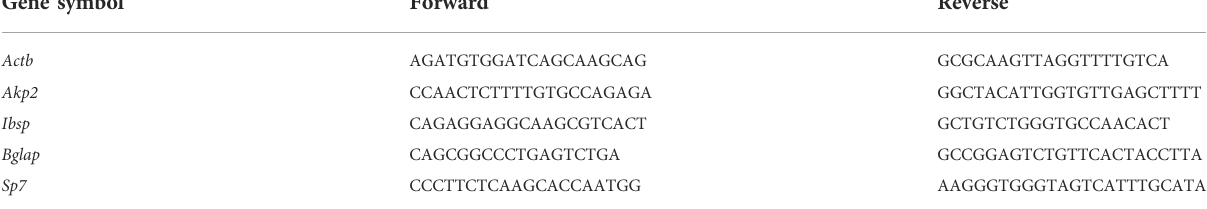
TABLE 1 RT-qPCR primer